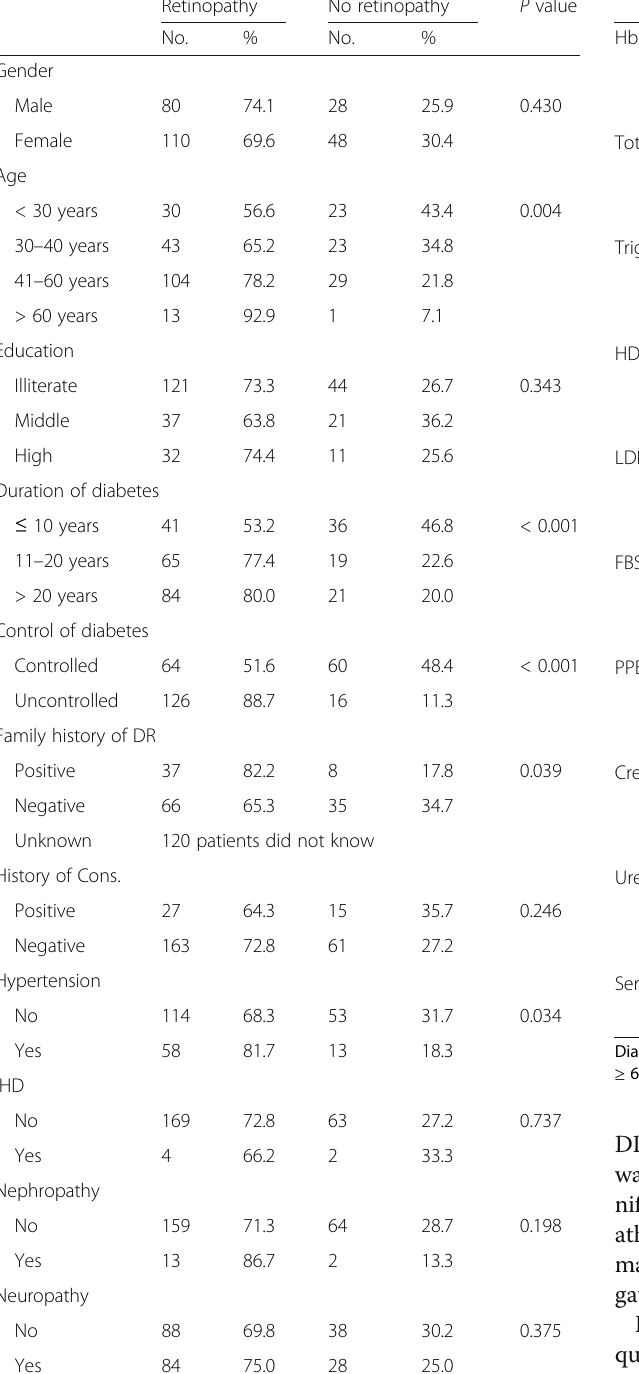
Table 2 Clinical characteristics of patients grouped according to the presence of DR